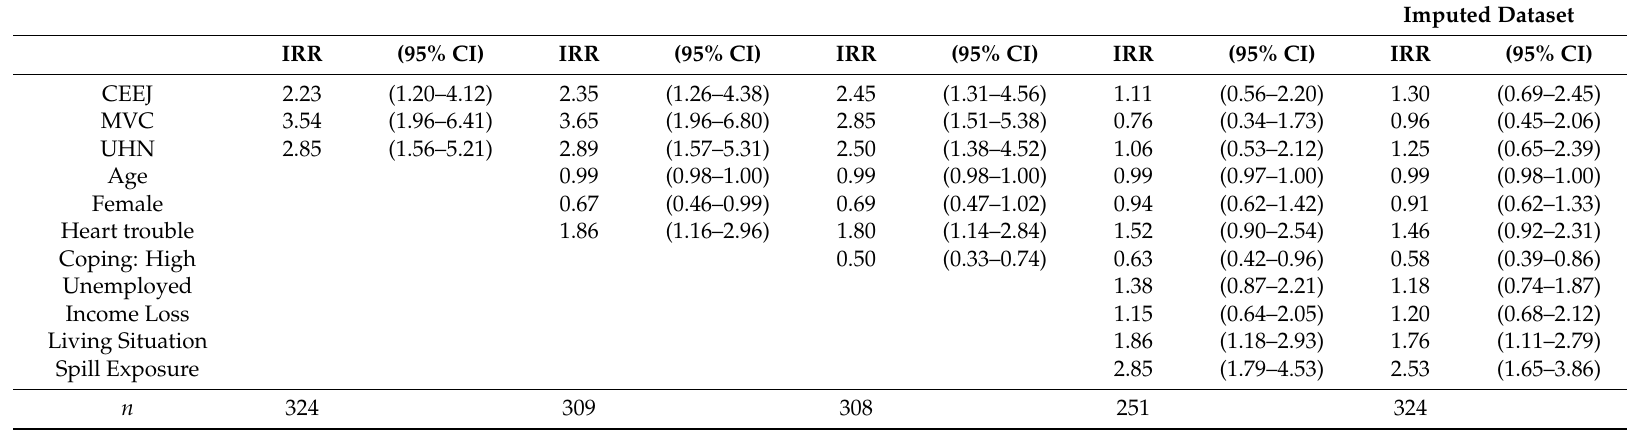
Table 3. Negative binomial regression predicting count (IRR) of PTSD measures following the oil spill among adults 18 years and older in the GC-HARMS